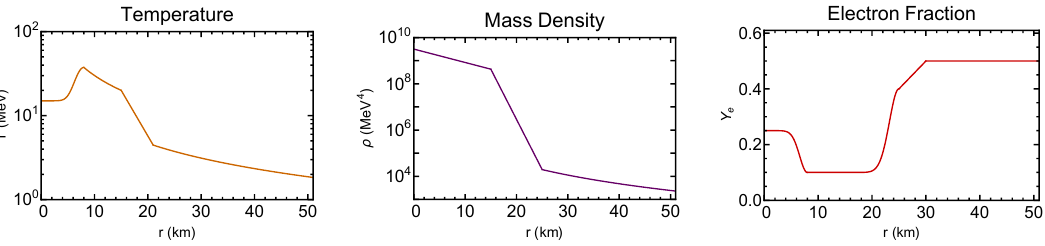
Figure 9 . The temperature, mass density, and electron fraction as a function of radius of the su-